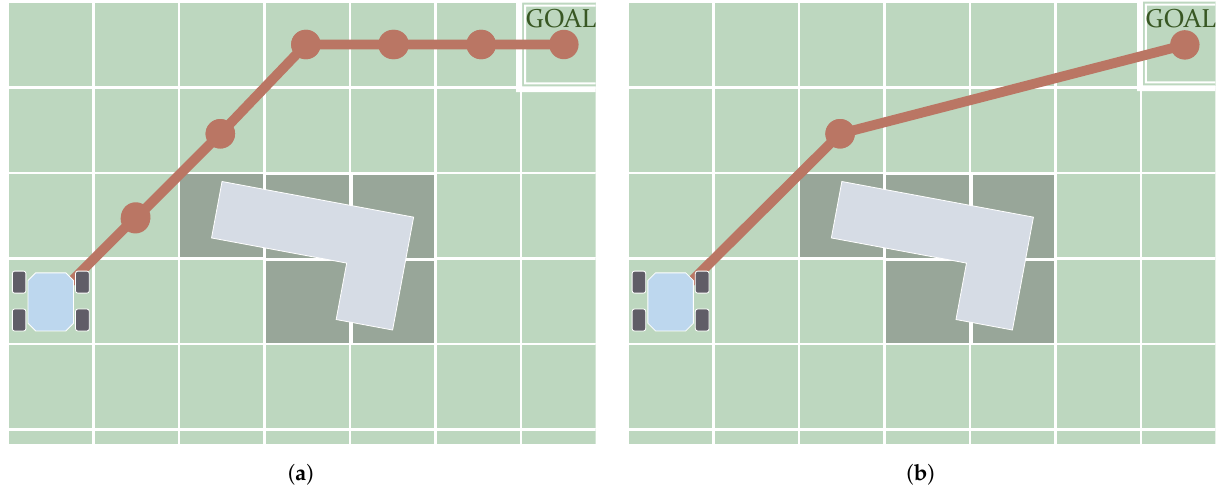
Figure 8. Main difference between the paths (in red) produced by Edge-restricted ( a ) and Any-angle algorithms ( b ): in the first case, waypoints can be placed only on consecutive (neighboring)